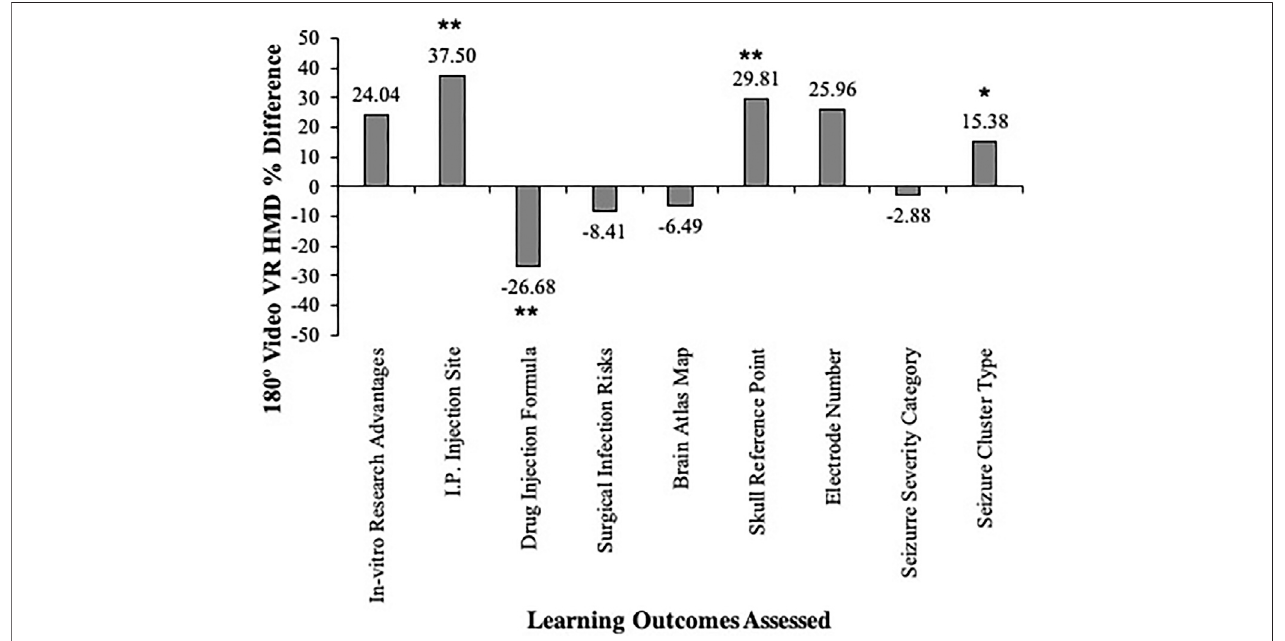
FIGURE4| Between-groupsparticipants ’ learningoutcomesassessed.Thedatashowthatthe180 ° videoVRHMDexperienceincreasedthestudent ’ slearningof the in-vivo researchadvantages, thei.p.injection site( p < 0.01**), theskullreferencepoints( p < 0.01**), theelectrode number, and theseizure clustertype ( p < 0.05*).In contrast, the 3D video computer display increased the learning of the drug injection formula ( p < 0.01**), the surgical infection risks, the brain atlas map, and the seizure severity type. The data are illustrated as the mean ± SEM and the statistical signi fi cance is denoted as p < 0.05*, p < 0.01**, and p < 0.001***.